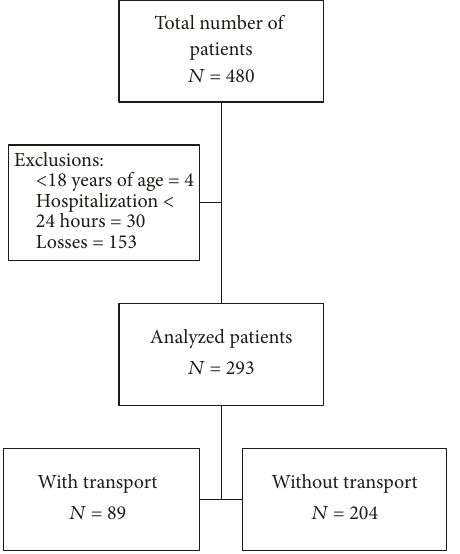
Figure 1: Flowchart of the study